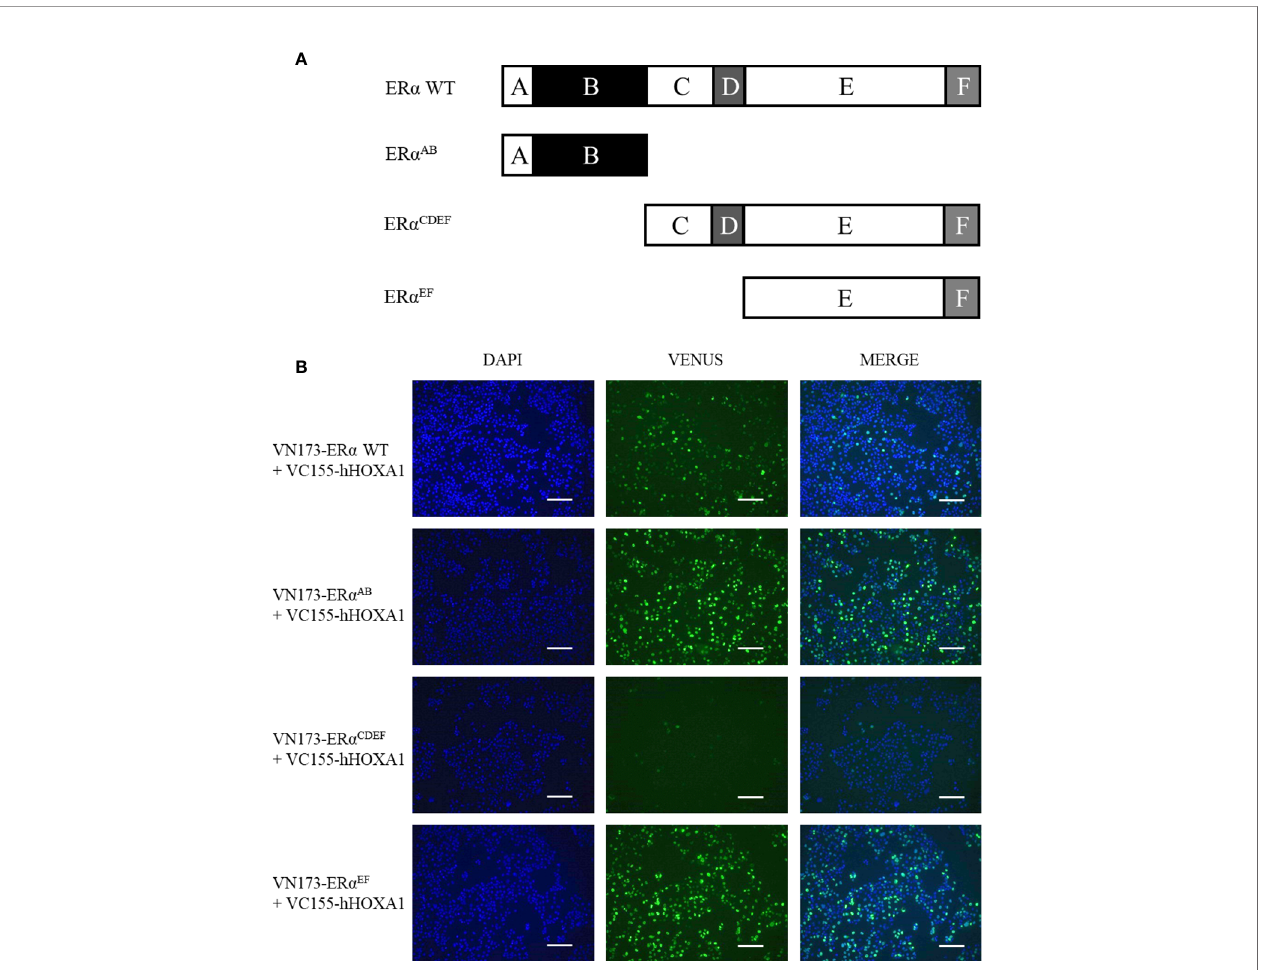
FIGURE 7 | Mapping ER a regions important for the HOXA1 interaction. (A) Maps of ER a regions and deletion variants. ER a WT (595 amino acids) is divided in six regions, from A to F In absence of ligand, region A can bind the C-terminal end and represses the transcriptional activity of the protein. Region B spans the transactivation domain AF-1, responsible for co-activator recruitment. Region C is the DNA-binding domain (DBD), structured in two zinc fi ngers. Region D is a hinge. Region E encompasses the ligand-binding domain (LBD) and the second transactivation function AF-2. Region F is a protein-protein interaction interface. hER a AB is 180 amino acid long, hER a CDEF is 415 amino acid long, hER a EF is 293 amino acid long. (B) Interaction between HOXA1 and ER a deletion variants. COS7 cells were transfected with plasmids encoding VC155-HOXA1 and VN173-ER a AB , VN173-ER a CDEF and VN173-ER a EF respectively. While ER a AB and EF variants maintained the interaction with VC155-HOXA1, ER a CDEF failed, as revealed by the absence of BiFC fl uorescence (N ≥ 3, n=2). Scale bars represent 200 µm; N, number of experiments; n, number of replicates per experiment.